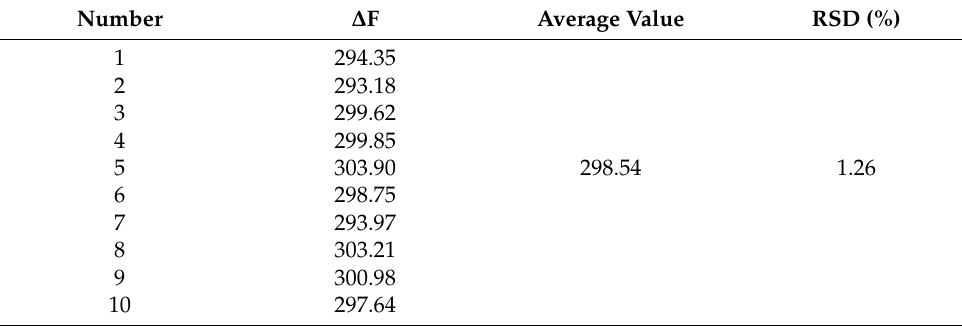
Table 1. Precision test of the F6 probe for Al 3+ detection.